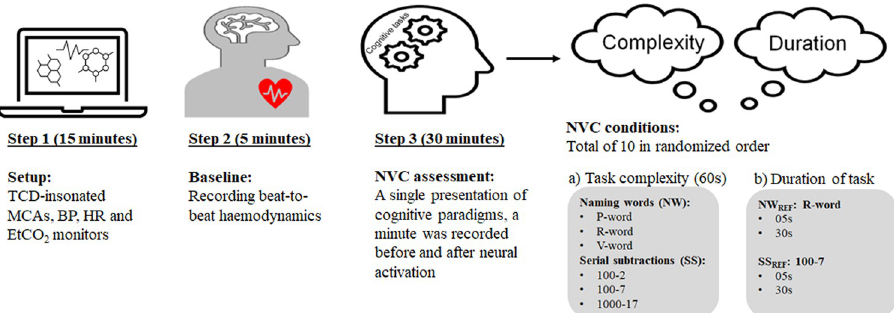
Fig 1. Protocol and experimental setup. Changes in cerebral haemodynamics were recording with transcranial Doppler (TCD) insonated bilateral middle cerebral arteries (MCAs) during cognitive stimulation. Blood pressure (BP), Heart rate (HR) and End-tidal CO 2 (EtCO 2 ) were simultaneously